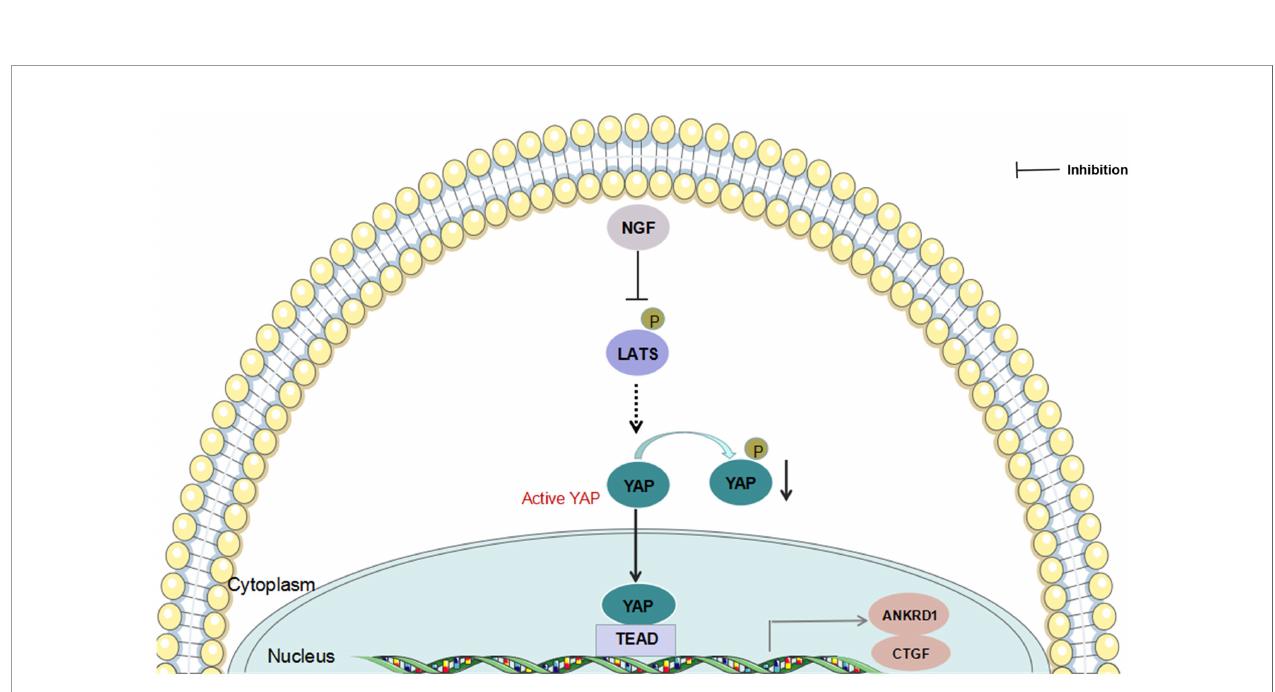
FIGURE 6 | Schematic presentation of NGF-induced regulation of YAP function.